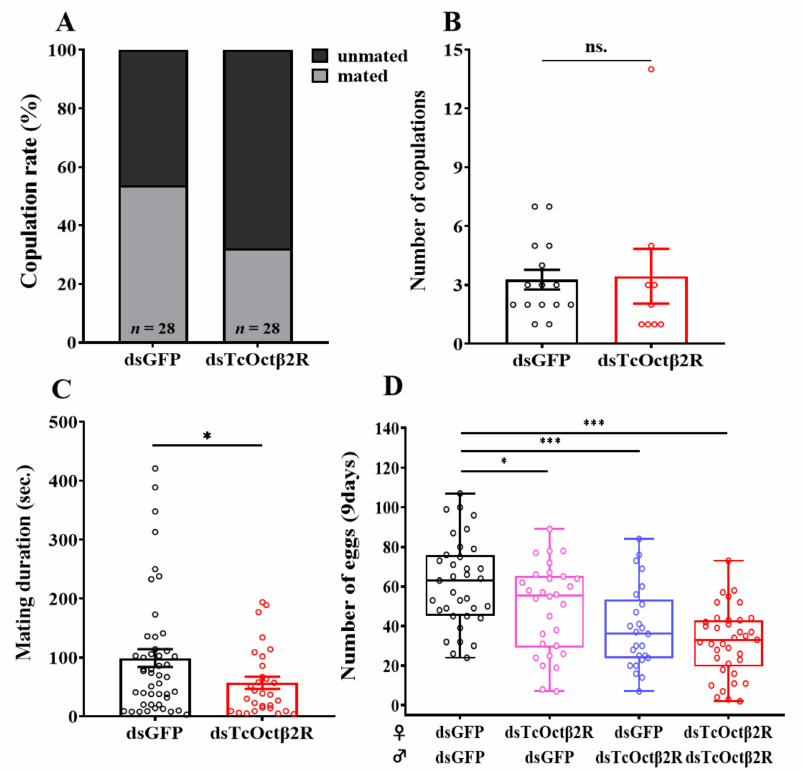
Figure 6. Mating behavior and fecundity assay after RNAi: ( A ) copulation rate (%); ( B ) number of copulations (mean ± S.E.) in 90 min; ( C ) mating duration ( n = 28); ( D ) total number of eggs laid in 9 d ( n = 13–14, mean ± S.E.). Asterisks represent the significant difference in independent t -test ( n = 25–37, * p < 0.05, *** p